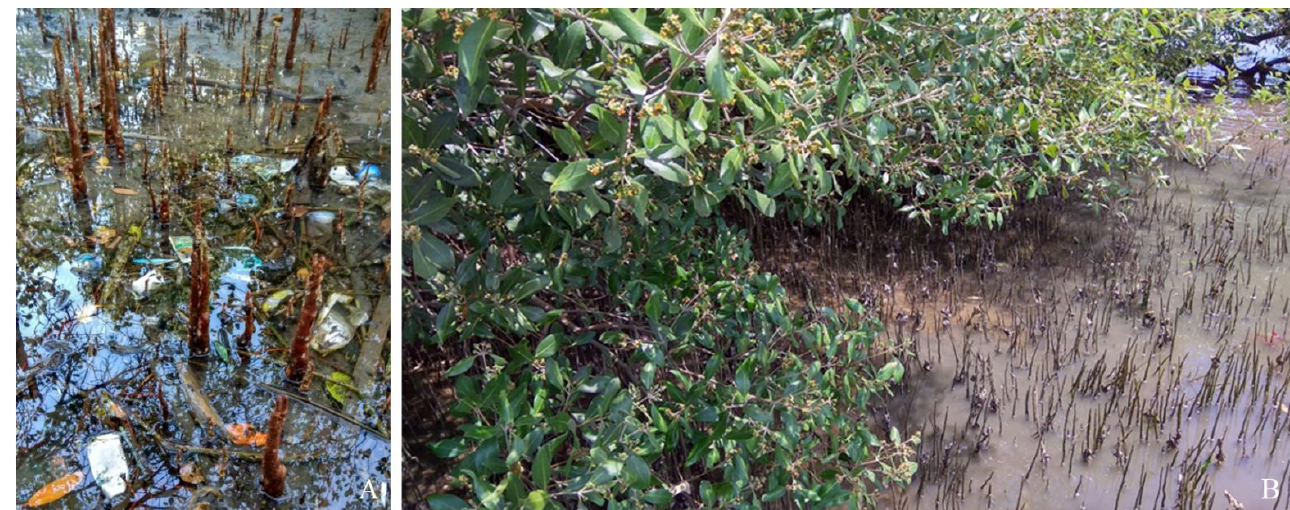
Figure 5. Sampling locations in market ( A ) and rural areas ( B ).